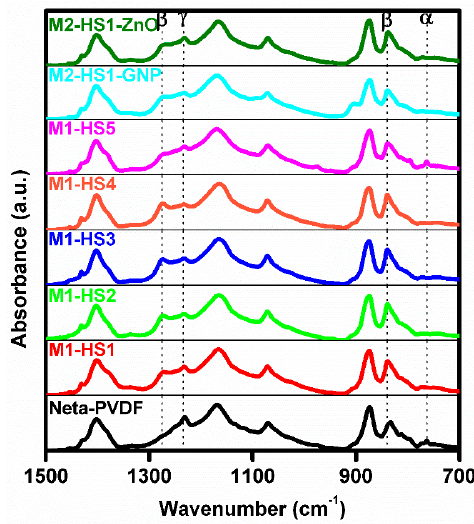
Figure 5. FT-IR spectra of PVDF nanocomposite samples.